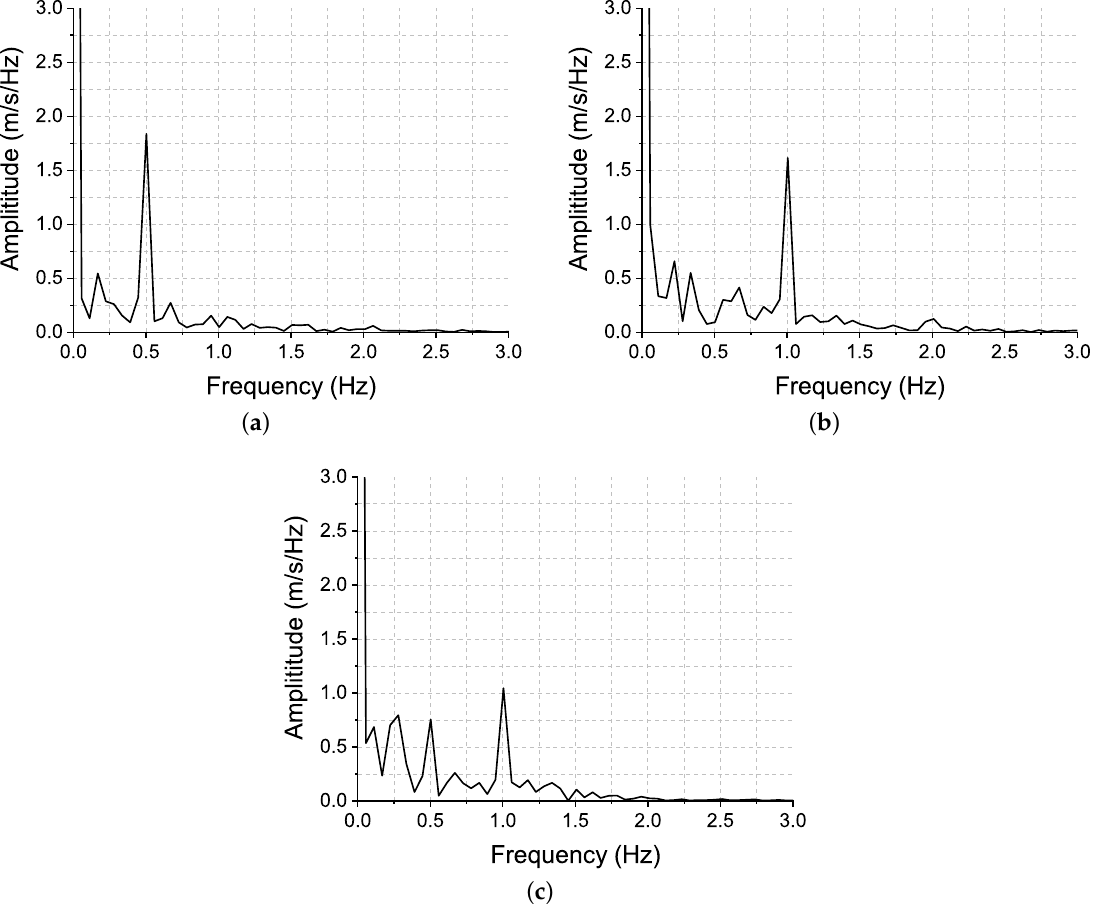
Figure 10. Variation of V N in frequency domain with dynamic inlet flow. ( a ) Case 4. ( b ) Case 5. ( c ) Case